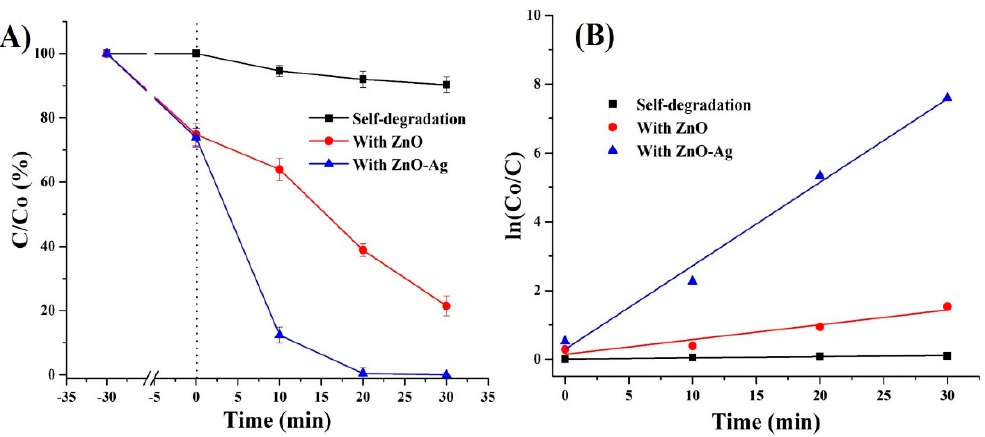
Figure 3. RB dye photodegradation ( A ) and linear fitting ( B ) of ln( Co/C ) as a function of time.